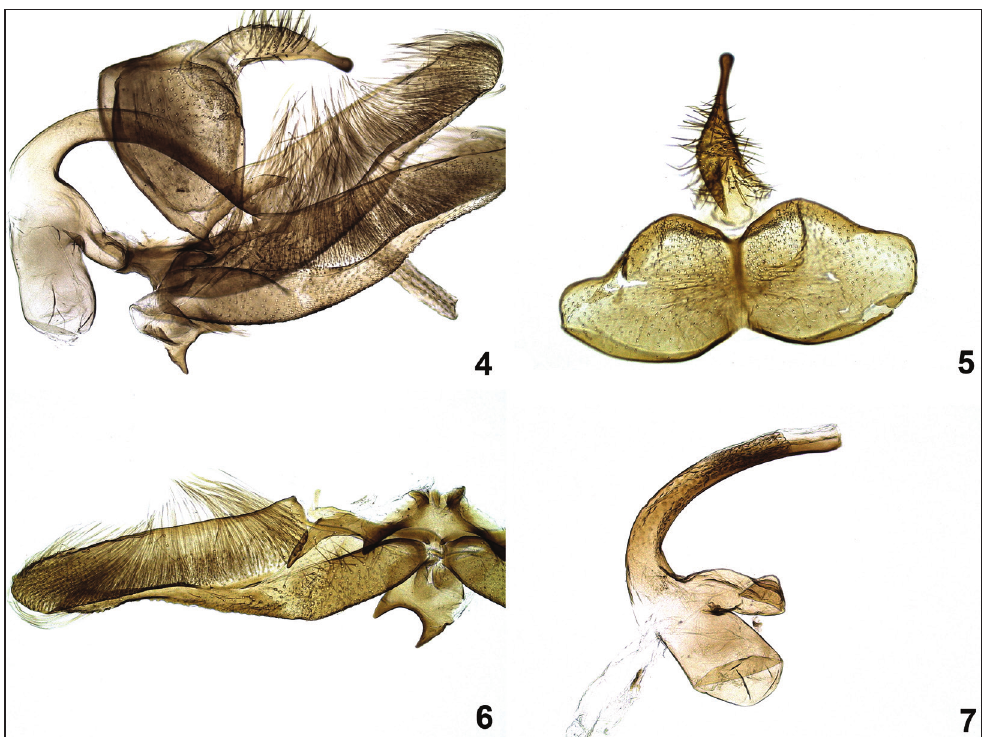
Figures 4–7. Platyptilia galicicaensis sp. n., male genitalia: 4. male genitalia, lateral view (GPJJ201607); 5. unrolled tegumen with uncus; 6. valva with saccus and anellus; 7. phallus.